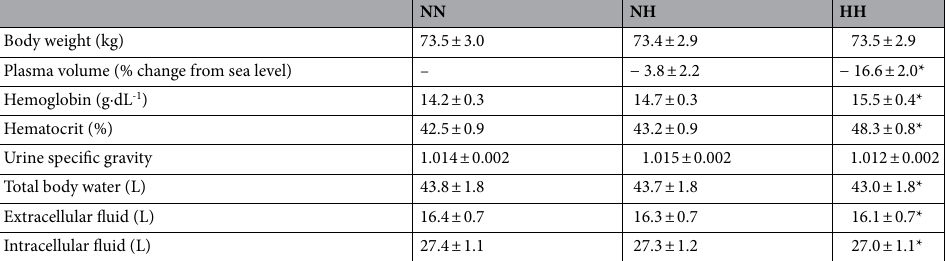
exercise was significantly higher during the HH exposure than the NH exposure ( p = 0.001) (Table 1). Nude body weight and body fluids. Nude body weight did not significantly differ across environments ( p = 0.536) (Table 2). Hemoglobin was significantly higher during the HH exposure compared to NN ( p < 0.001) and the NH exposure ( p = 0.005) with a trend for hemoglobin to be significantly lower during the NH exposure than NN ( p = 0.052) (Table 2). Similarly, hematocrit was significantly higher during the HH exposure compared to NN ( p < 0.001) and the NH exposure ( p < 0.001) (Table 2). There was no difference in hematocrit between the NH exposure and NN ( p = 0.255) (Table 2). Plasma volume normalized relative to NN was significantly lower during the HH exposure compared to the NH exposure ( p < 0.001) (Table 2). USG was not significantly different between environments ( p = 0.169) (Table 2). Total body water, extracellular fluid, and intracellular fluid were sig- nificantly lower during the HH exposure compared to NN ( p < 0.001, p < 0.001, and p = 0.001, respectively), not significantly different between the NH exposure and NN ( p = 0.492, p = 0.696, and p = 0.420, respectively), and significantly lower during the HH exposure compared to the NH exposure ( p = 0.006, p = 0.006, and p = 0.016,